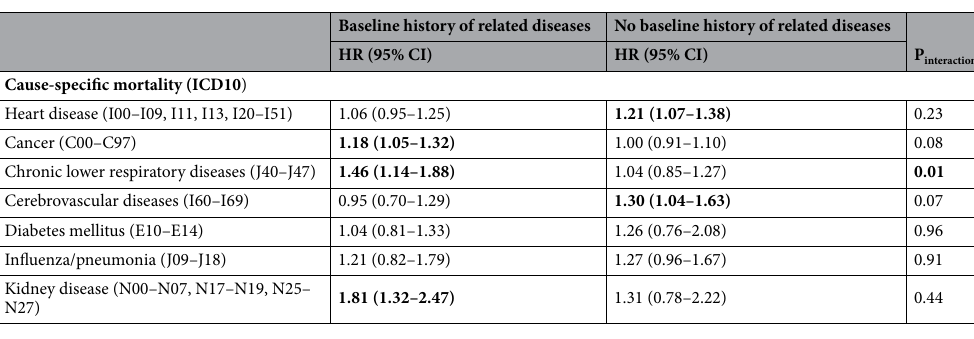
Table 4. Associations of neutrophil-to-lymphocyte ratio with cause-specific mortality in individuals with or without specific diseases at baseline. Hazard ratios describe the change in mortality corresponding to a 1-quartile increase in neutrophil-to-lymphocyte ratio. Models are adjusted for age (continuous); sex; race/ ethnicity (non-Hispanic white, non-Hispanic black, Mexican American, other Hispanic, other race); smoking (never, former, current smoker), body mass index (< 18.5, 18.5–24.9, 25–29.9, ≥ 30 kg/m 2 ); baseline presence of diabetes mellitus, hypertension, and arthritis; and total white blood cell count, except for the model for diabetes mellitus-specific mortality, which did not include adjustment for diabetes mellitus. Bolded values indicate statistical significance. CI confidence interval, HR hazard ratio, Q